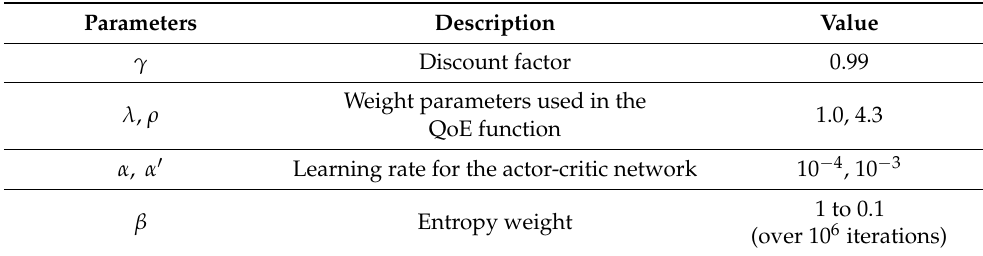
Table 1. Parameters and their values used in the proposed scheme. Parameters Description Value γ Discount factor 0.99 Weight parameters used in the λ , ρ 1.0, 4.3 QoE function α , α (cid:48) Learning rate for the actor-critic network 10 − 4 , 10 − 3 1 to 0.1 β Entropy weight (over 10 6